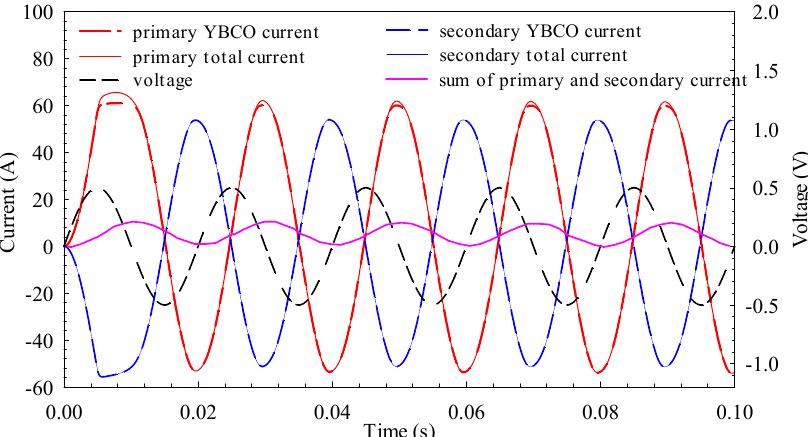
Figure 6. Simulation results of voltage and current curves at voltage magnitude of 0.5 V.